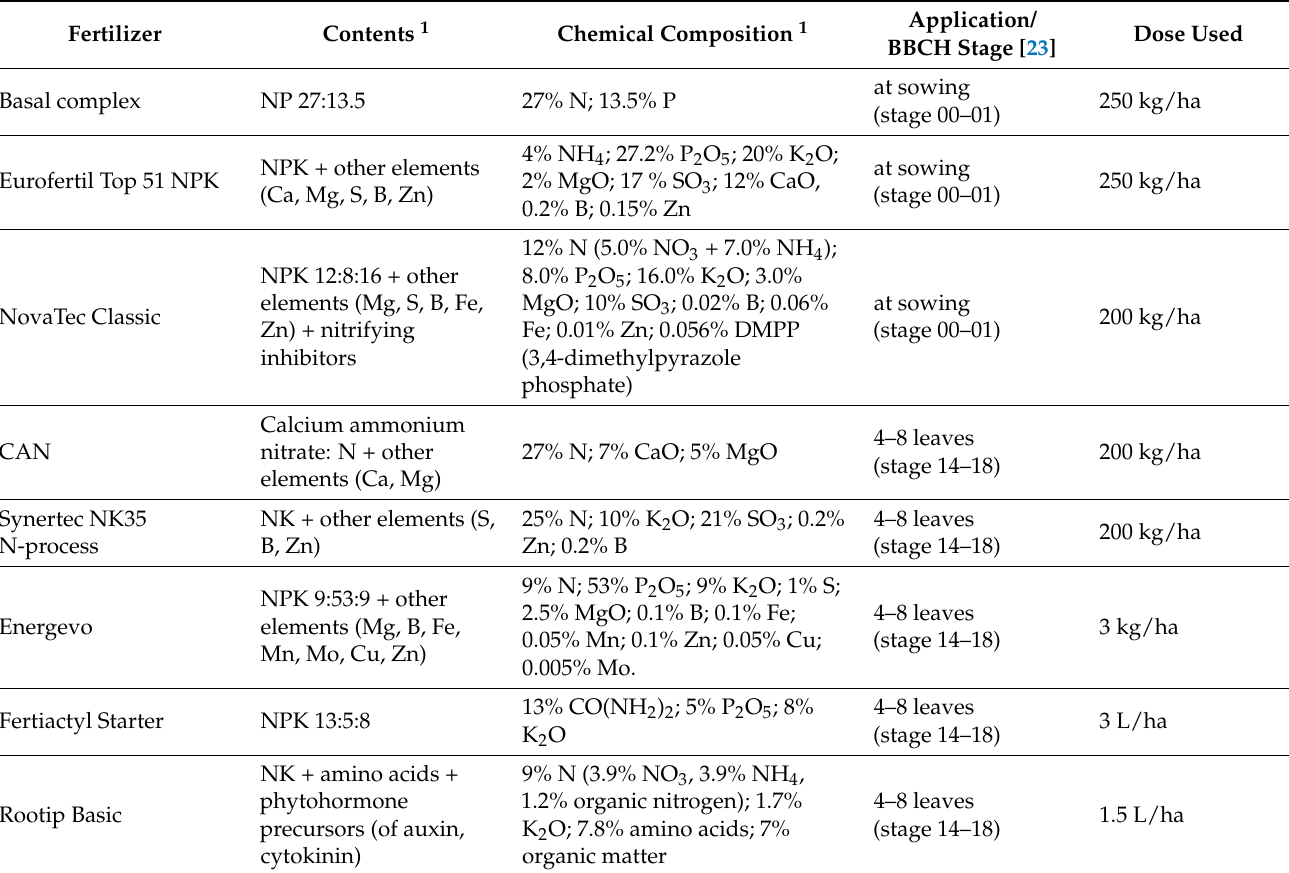
Table 1. Fertilization products used for different combinations and their